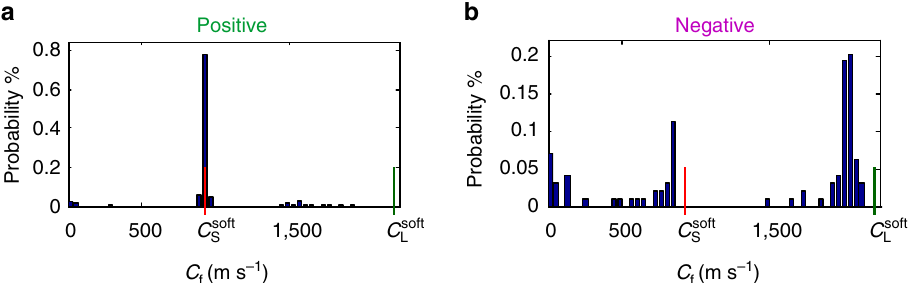
Figure 4 | Rupture velocities are sharply selected in the positive direction whereas supershear dominates negative direction ruptures. ( a ) Histogram of 213 steadily propagating (Methods) ruptures in the positive direction for various experimental loading conditions and 2,000 o F N o 6,000N. ( b ) Histogram of 98 steadily propagating ruptures in the negative direction, conditions as in a . Green and red lines denote, respectively, C L soft and C S soft . Note the sharp selection (88% of all primary ruptures) at C S soft in the positive direction whereas C S soft is never observed in the negative